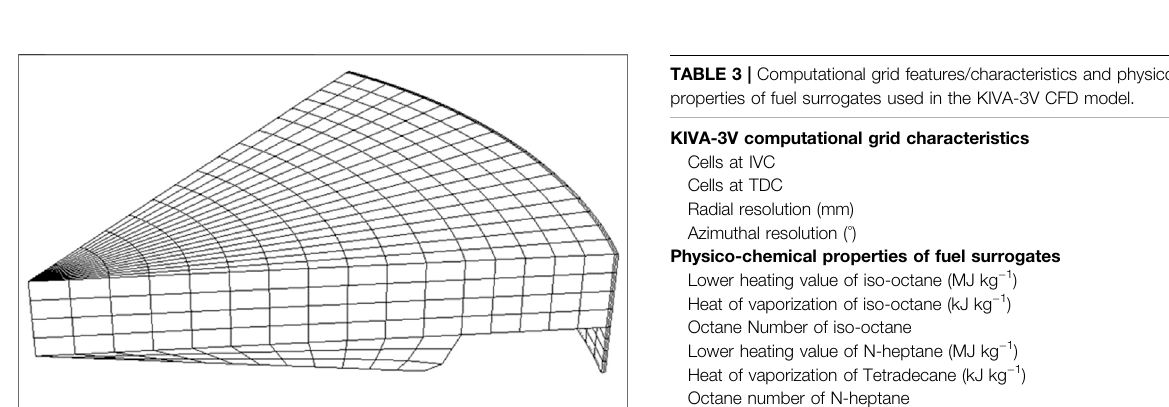
FIGURE 2 | Sector mesh of GM 1.9 L engine cylinder used for KIVA-3V simulations.